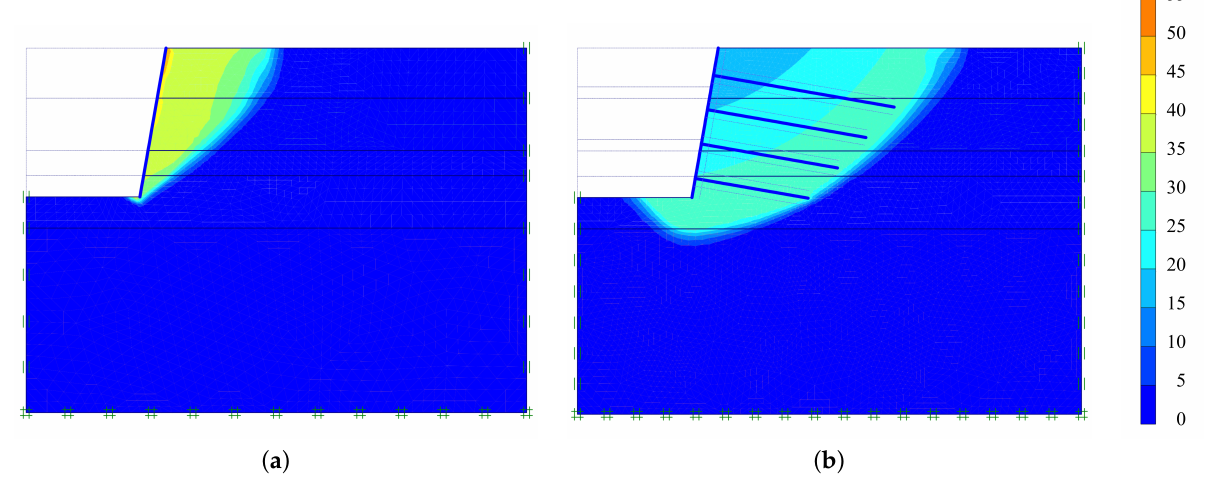
Figure 2. Distribution of total displacements for the case of: ( a ) excavation without soil-nailing support; ( b ) excavation with soil-nailing support, and their corresponding critical sliding